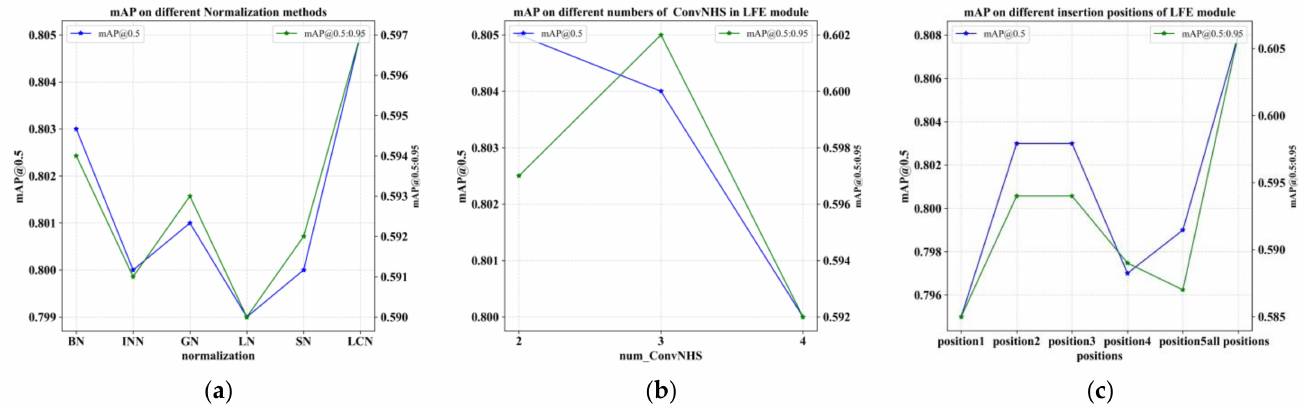
Figure 7. mAP line charts of the different integration schemes of LFE. ( a ) shows the experimental results of different normalization methods in the LFE module. ( b ) shows the experimental results of different numbers of ConvNHS in the LFE module. ( c ) shows the experimental results of LFE modules at different insertion positions of